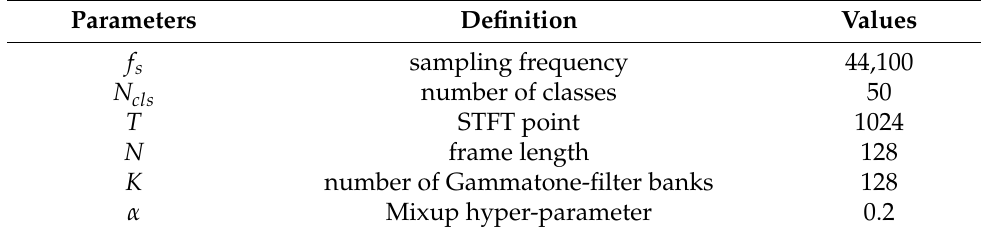
Table 8. Parameter settings in